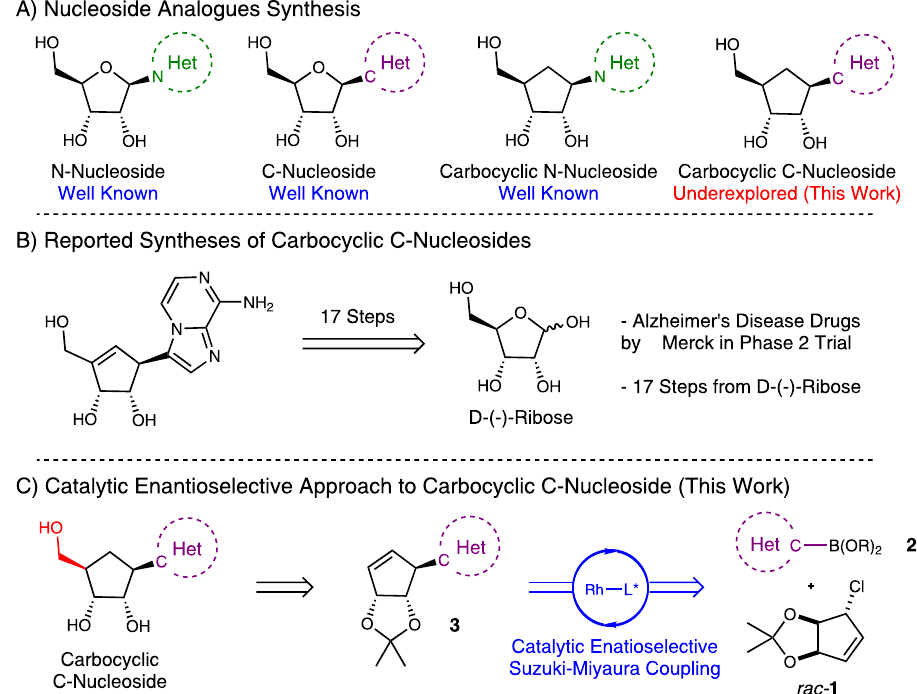
Fig. 2 Classi fi cation and synthesis of carbocyclic C-nucleosides. A Nucleoside analog synthesis. B Reported syntheses of carbocyclic C-Nucleosides.